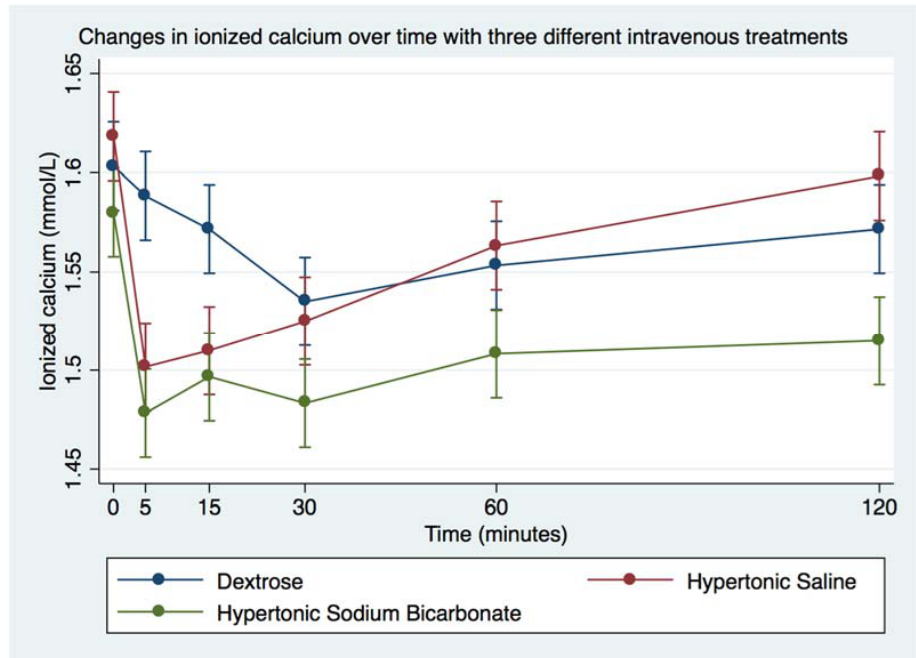
Figure 8. Overall effect of treatment on the blood ionized calcium (Ca 2+ ) over time. The mean and SEM venous blood Ca 2+ for all six horses. Blue = Treatment Group DS (5% dextrose solution at 2 mL/kg bwt); Green = Treatment Group HB (NaHCO 3 8.4% solution at 2 mmol/kg bwt); and Red = Treatment Group HS (NaCl 7.5% solution at 4 mL/kg bwt).